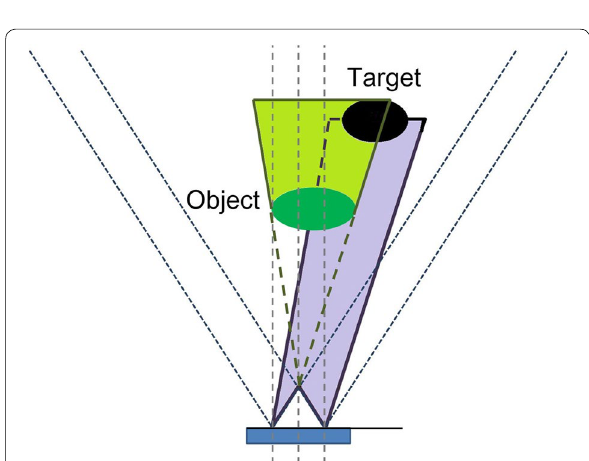
Fig. 8 Definition of Region B. The green region indicates where the object hides in the